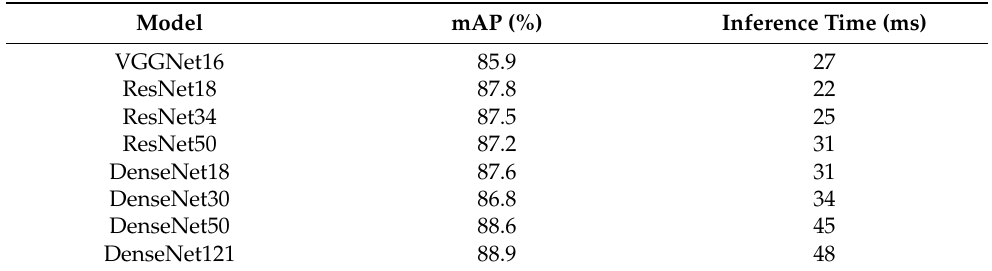
Table 2. Values of mean average precision (mAP) and inference time of the eight models.